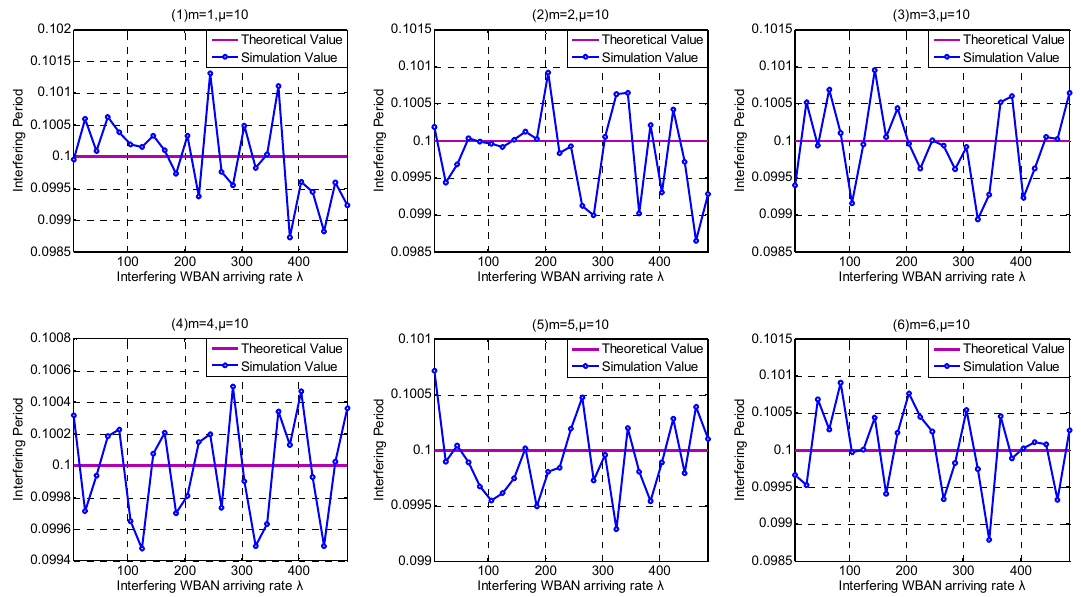
Figure 22. Interfering Period in Service-independent